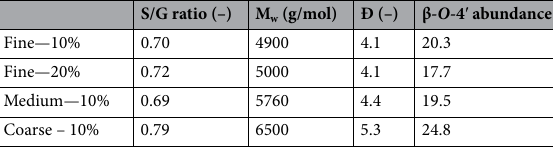
Table 5. Lignin characteristics at the 1 L scale as a function of solid loading and particle size.